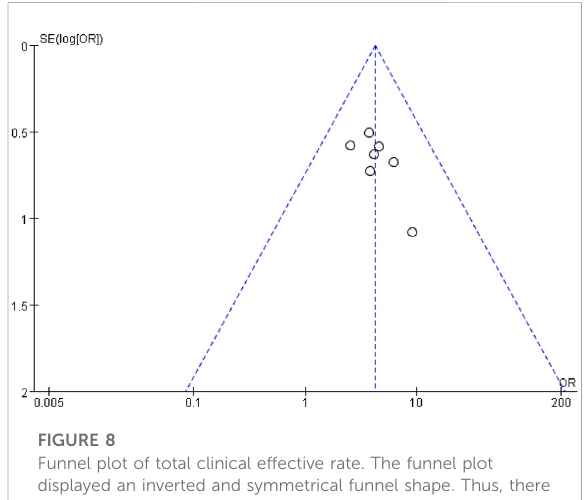
FIGURE 8 Funnel plot of total clinical effective rate. The funnel plot displayed an inverted and symmetrical funnel shape. Thus, there was no clear evidence of publication